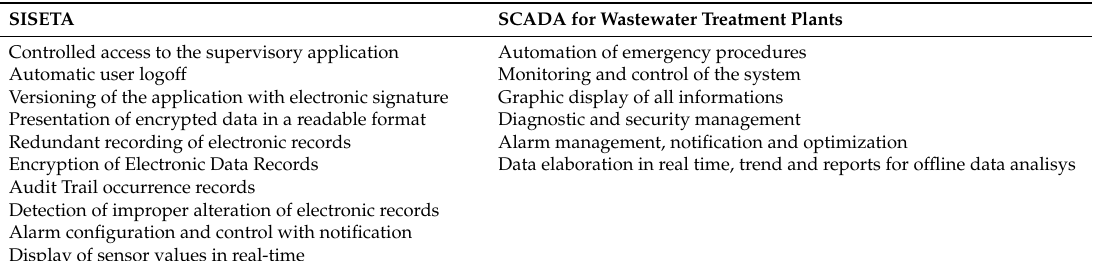
Figure 12. Screen of reverse osmosis system (SISETA). Table 3. Main requirements for the validation of the supervisory system